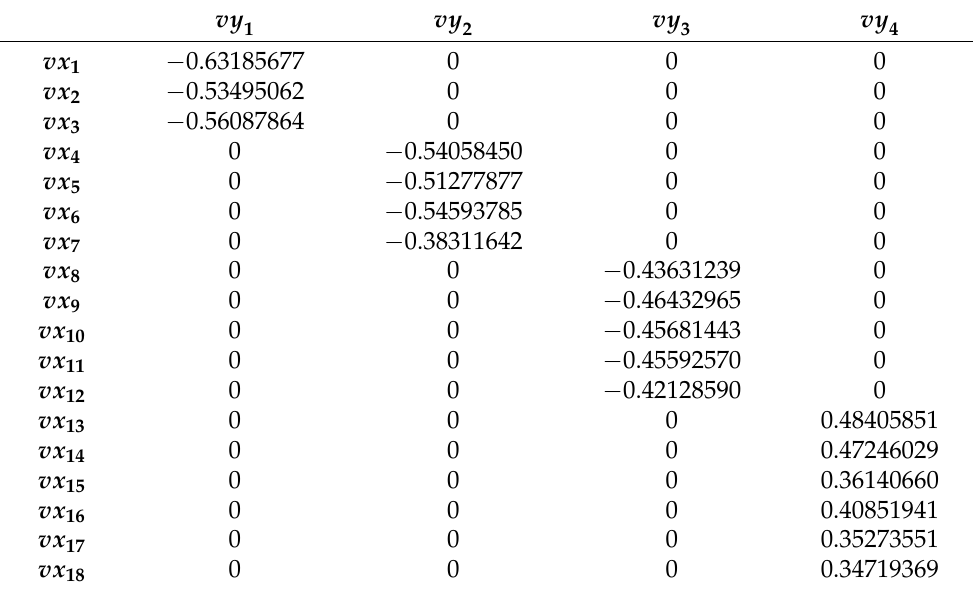
Table 16. Loading matrix B with the DisjointTuckerALS algorithm for simulated